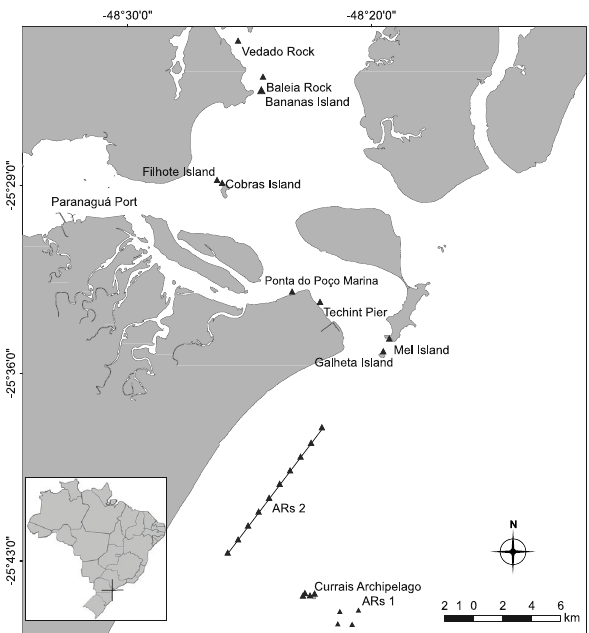
Figure 1. Location of field survey sites, state of Paraná, southern